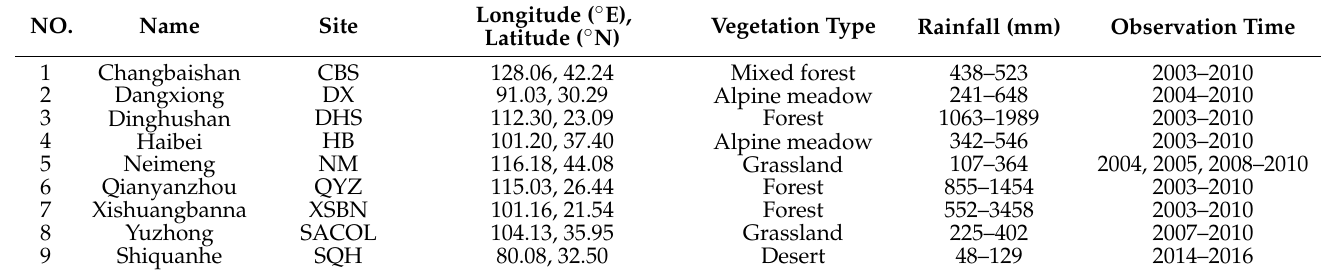
of the regulation mechanisms, as shown in Table 2.